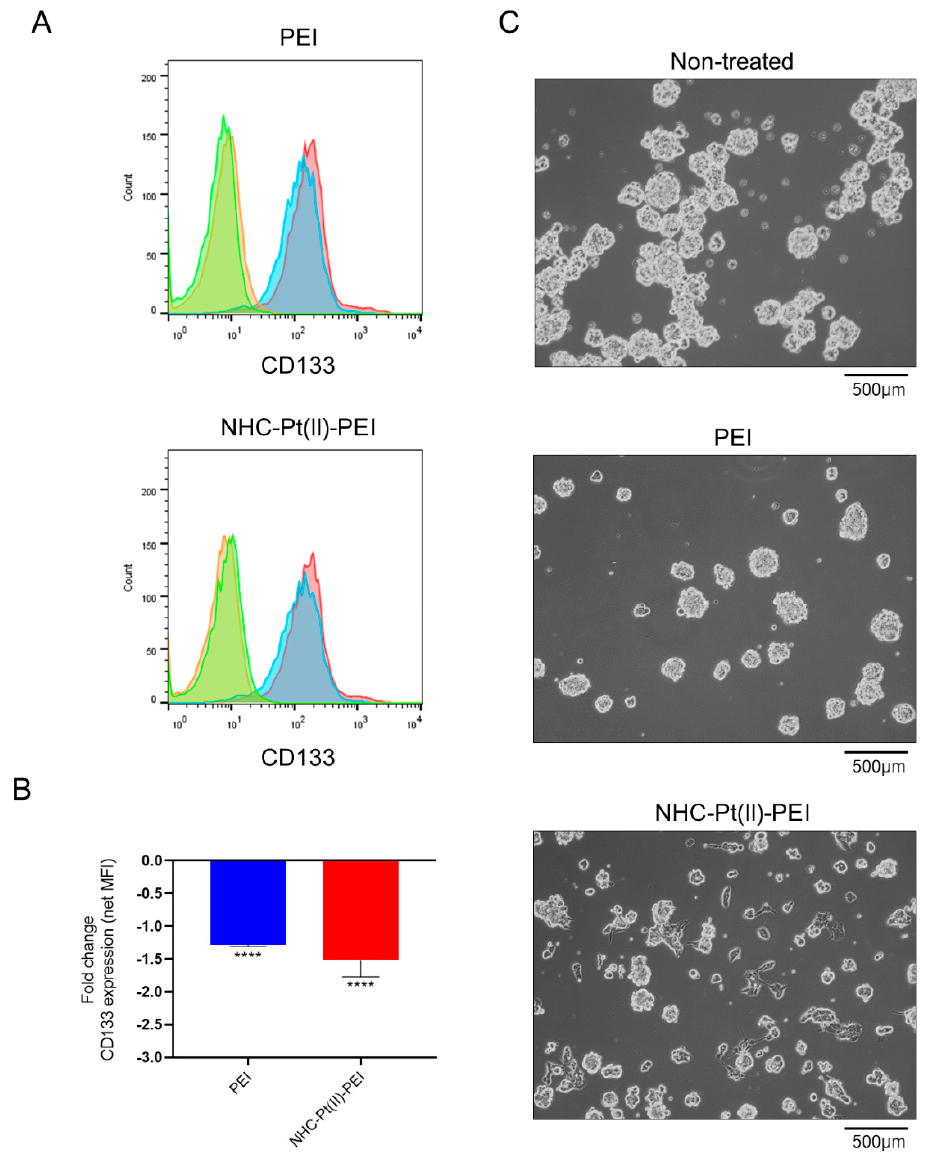
Figure 9. Loss of CD133 CSC marker and CSC morphology of NCH421K cells treated for 4 days with 375 nM NHC-Pt(II)-PEI and PEI eq. ( A ) Representative flow cytometry fluorescence histograms (FlowJo v10) showing a reduction in CD133 fluorescence on NCH421K cells. Orange = EtOH control isotype. Green = PEI or NHC-Pt(II)-PEI treated isotype. Red = Vehicle-treated CD133 stained. Blue = PEI or NHC-Pt(II)-PEI CD133 stained. ( B ) Histograms showing fold change in CD133 net geometric mean fluorescence intensity (MFI stained—MFI isotype) vs. vehicle-treated control. Values represent the mean of at least n = 3 independent experiments. Statistics represent Student’s t -tests with a Welch’s correction vs. the corresponding vehicle reference. Distribution normality was confirmed using a Shapiro–Wilk test. **** = p ≤ 0.0001. ( C ) Inverted light microscopy images of treated NCH421K cells at 4 × 10 × = 40 × magnification were taken using an Axio Vert A1 inverted light microscope (Zeiss) microscope coupled to a ProgRes C5 cool (Jenoptik, Jena, Germany) camera.